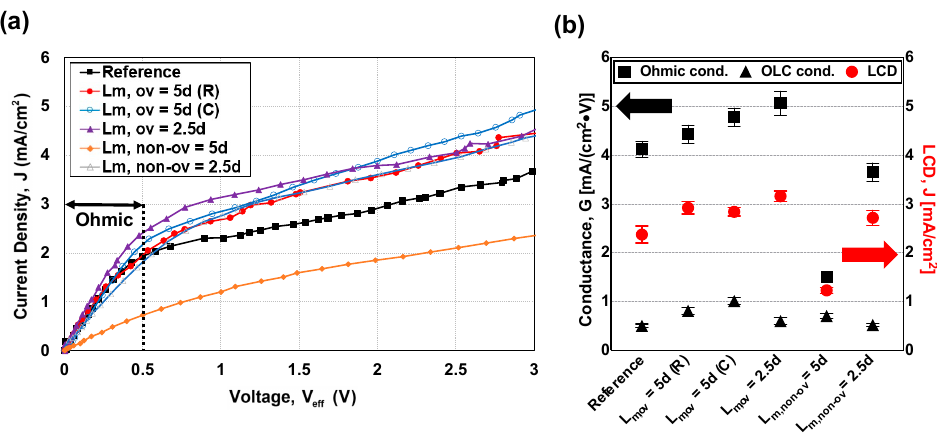
Figure 5. Electrical responses of the six different types as revealed by ( a ) current density–voltage curves. The current was measured between the anode and the cathode at a voltage sweep rate of 0.2 V/30 s, from 0 to 3 V. The voltage (V eff ) was measured by Ag/AgCl electrodes; this was the cell voltage of the main (dilute) channel. ( b ) Ohmic conductances and limiting current densities (LCD). The Ohmic conductances were calculated from the experimental data (the J–V curve) of the Ohmic (V eff < 0.5 V) regime at a limiting current density of V eff = 0.5 V. All experiments were repeated at least three times; the results were similar. The Ohmic conductances indicated that the mass transports of L m,ov membranes were higher than the mass transports of the other patterned (L m,non-ov ) and reference